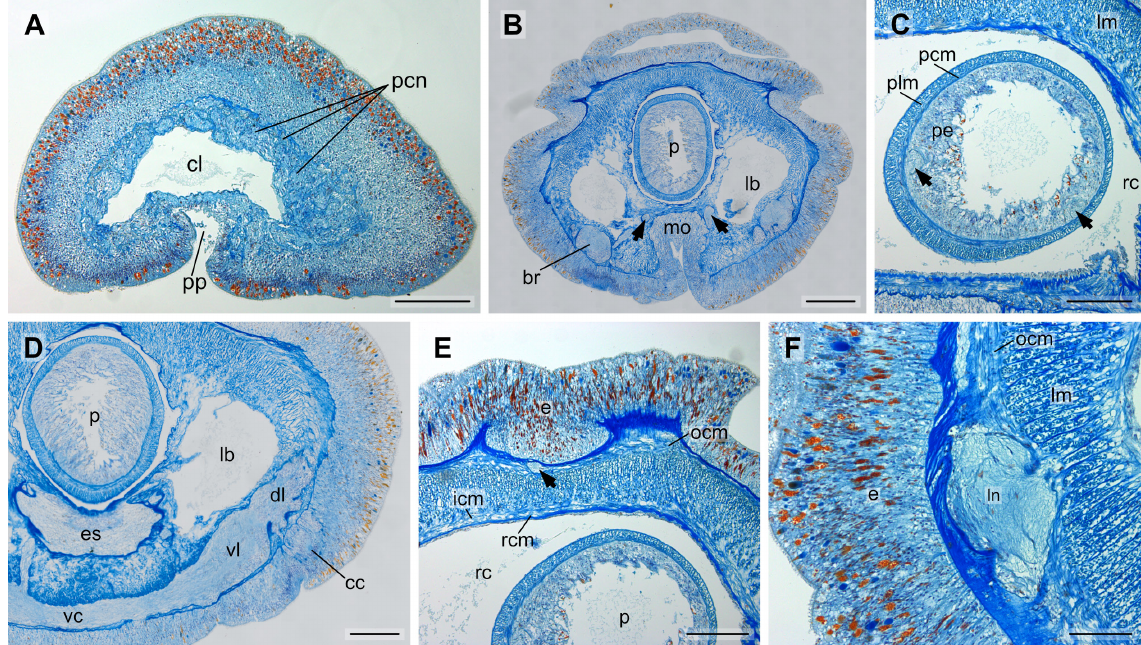
Fig. 4. Tubulanus cf. lutescens Cantell, 2001 (SIO-BIC N277), transverse histological sections. A . Anterior region of head with proboscis pore. B . Posterior brain region with mouth opening and buccal nerves (arrowheads). C . Proboscis composition and the two proboscis nerves (arrowheads) in the foregut region. D . Brain region showing the cerebral canal. E . Body wall composition in the foregut region, arrowhead indicates upper dorsal nerve. F . Lateral nerve cord in the foregut region. Abbreviations: br = brain; cc = cerebral canal; cl = cephalic loop; dl = dorsal brain lobe; e = epidermis; es = esophagus; icm = inner circular muscle layer; lb = lateral blood vessel; lm = longitudinal muscle layer; ln = lateral nerve cord; mo = mouth opening; ocm = outer circular muscle layer; p = proboscis; pcm = circular musculature of proboscis; pcn = precerebral nerves; pe = proboscis epithelium; plm = longitudinal musculature of proboscis; pp = proboscis pore; rc = rhynchocoel; rcm = circular musculature of rhynchocoel; vc = ventral commissure; vl = ventral brain lobe. Scale bars: A–C, E = 200 µm; D, F = 100